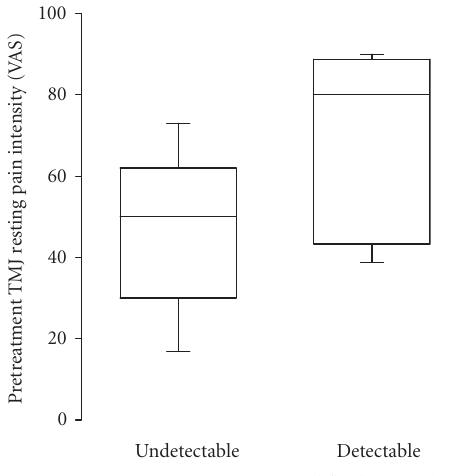
Figure 2: Box-plot (10th, 25th, 50th, 75th, and 90th percentiles) showing the relation between pretreatment TMJ synovial fluid level of tumor necrosis factor- α (TNF- α ) and the change in temporo- mandibular joint (TMJ) pain upon maximum mouth opening after intra-articular glucocorticoid treatment in 21 female patients with chronic inflammatory disorders of the TMJ ( r s = 0 . 51, n = 21, P = . 017). Four patients had an elimination and 17 had no change of TMJ pain upon maximum mouth opening. In the 7 patients with detectable pretreatment levels, 3 experienced an elimination and 4 no change in TMJ pain upon maximum mouth opening.